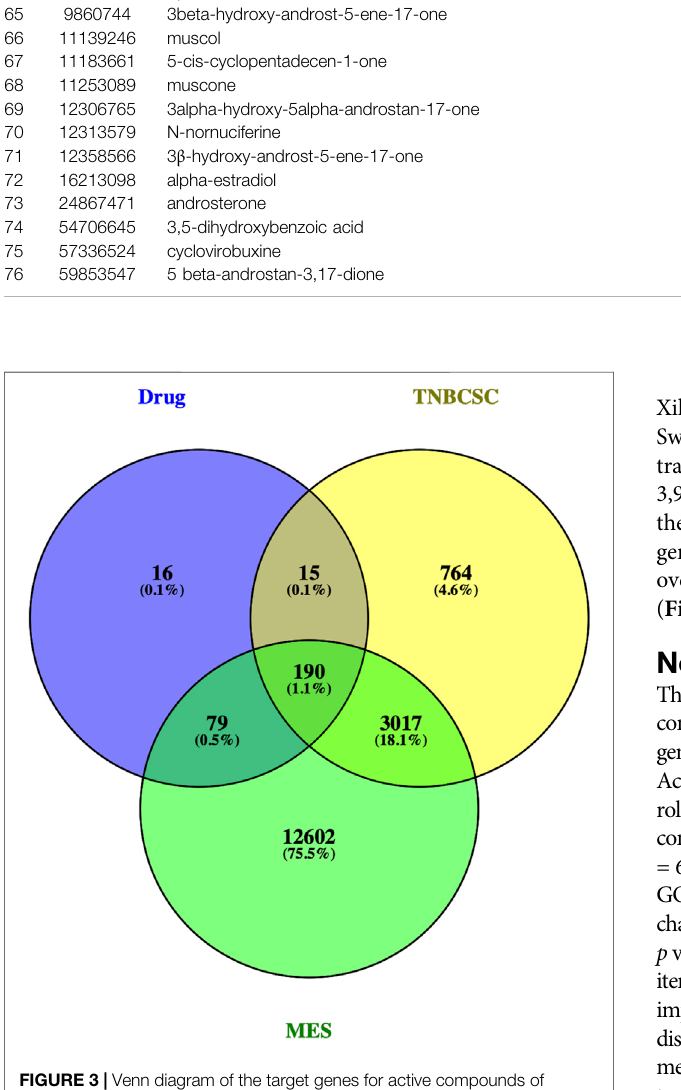
FIGURE 3 | Venn diagram of the target genes for active compounds of Xihuang pill, TNBC stem cells, and a mesenchymal-like (MES) subtype of TNBC. Active compounds of Xihuang pill has 300 target genes, TNBC stem cell has 3,968 related target genes, and the mesenchymal-like (MES) subtype of TNBC has 15,888 target genes. There are 190 overlapping target genes among the three sets.